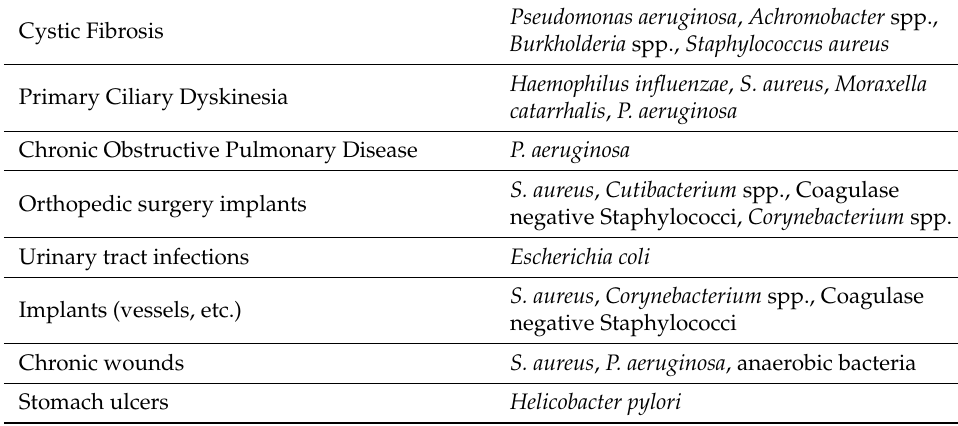
Pseudomonas aeruginosa , Achromobacter